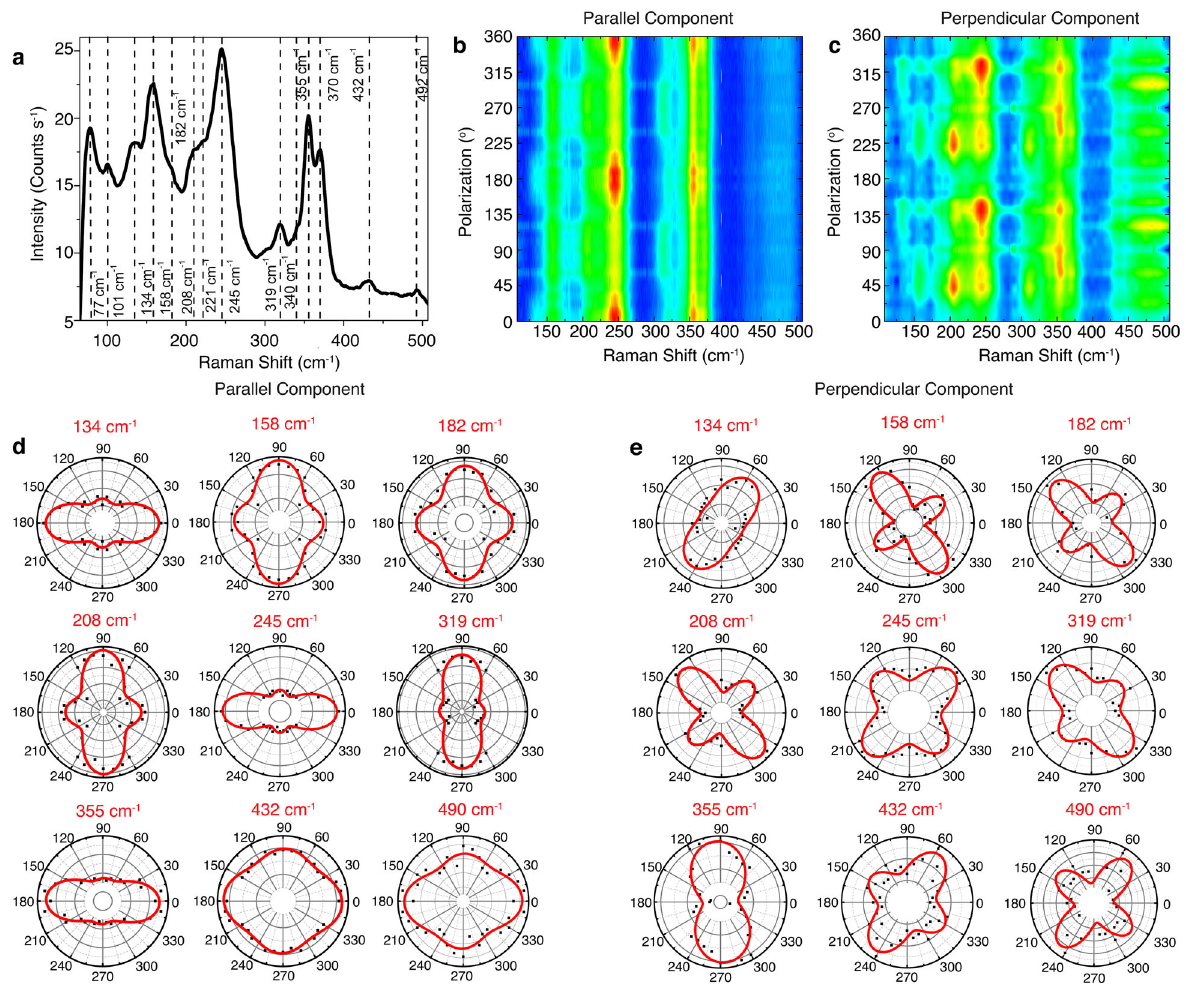
Fig. 3 Structural anisotropy of lengenbachite crystal revealed by Raman spectroscopy. a Representative Raman spectrum acquired from the 44 nm lengenbachite fl ake, where all the observed Raman modes are labeled. b , c Contour plots of the angle-resolved polarized Raman spectra obtained in parallel and perpendicular polarization con fi gurations. d Polar plots of the Raman intensities of parallel components for Raman modes at 134, 158, 182, 208, 245, 319, 355, 432, and 490 cm − 1 . The black points are the measured data and the red solid curves are the theoretical fi ts. e Corresponding polar plots of the Raman intensities of perpendicular components of the same Raman